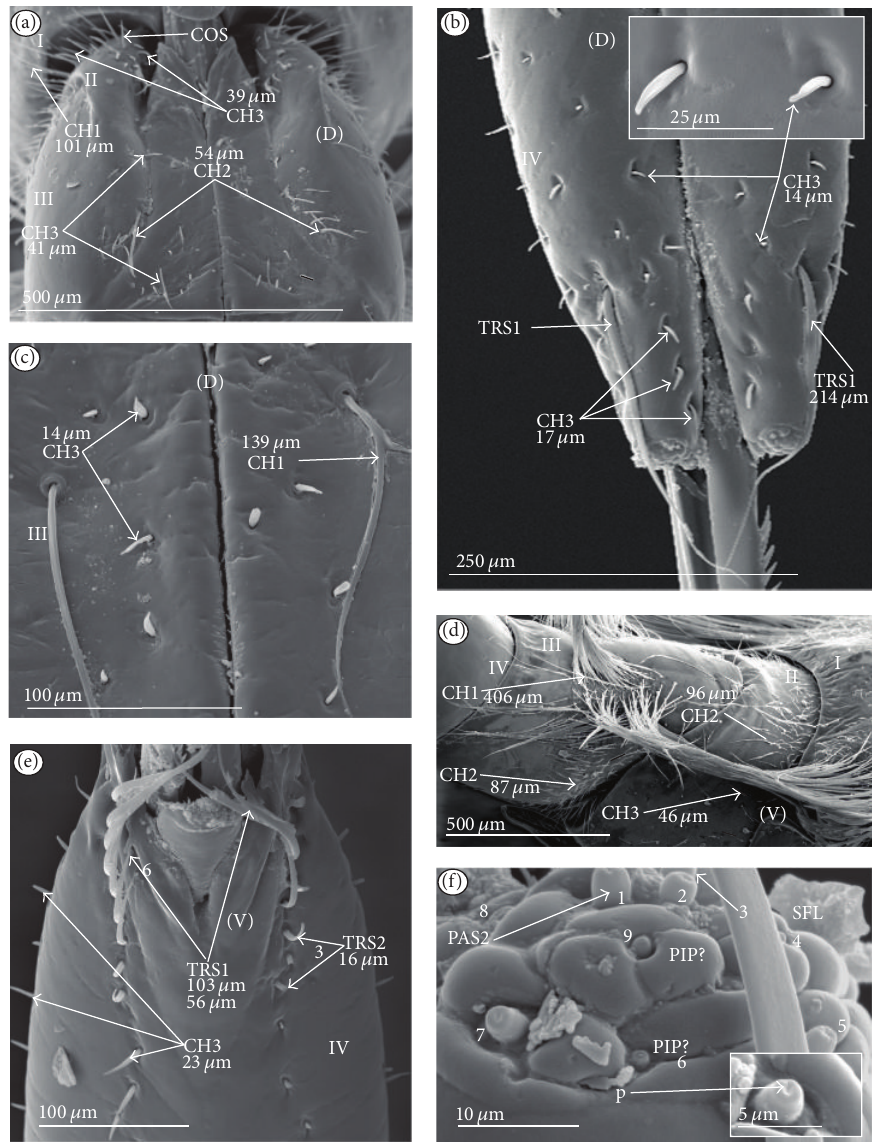
Figure 28: Types and sizes of the sensilla of the Notonectidae: Notonectinae ( Notonecta glauca ). (a) The arrangement of several CH2, CH3, and CH1 on the dorsal surface of the II segment; COS is situated near the edge of the I segment. (b) TRS1 (one pair) placed dorsally, near the apex; CH3 are numerous and distributed all over the surface of the IV segment (dorsal view). (c) CH1 and CH3 are situated in the distal part of the III segment. (d) CH1 are numerous and densely cover the ventral side of the II and I segments; CH2 are numerous and situated on the lateral side of the III segment; CH2 and CH3 are numerous and densely spread over the II and I segments (ventral view). (e) TRS1 (six) and TRS2 (three) are placed near the apex; CH3 are situated in two rows (ventral view, IV segment). (f) PAS2 (no. 1–7) and probably PIP (no. 6 or 9) are located on the sensory field (left-side view;